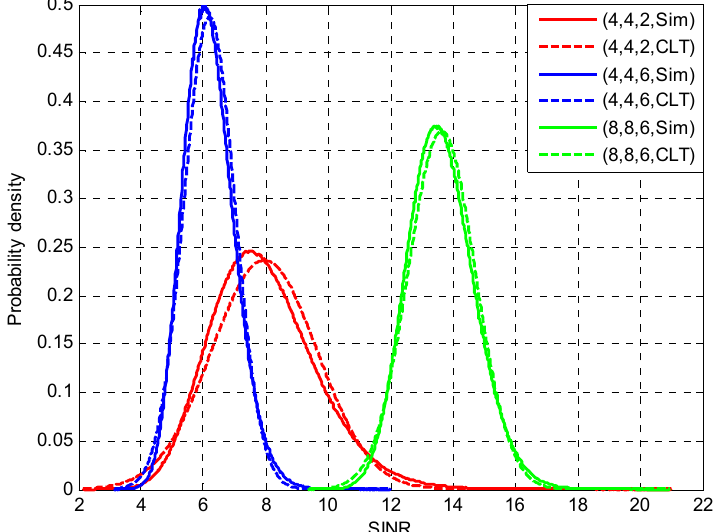
Figure 1. CLT curve fitting for various MIMO orientations.